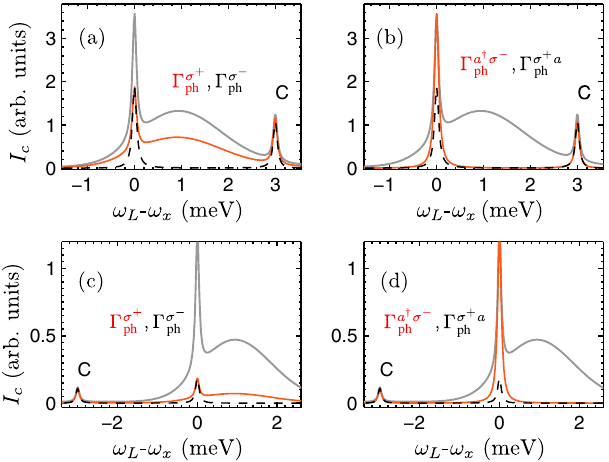
FIG. 3. (a) Influence of the effective phonon-scattering rates, (red line) and (cid:3) (cid:1) (cid:1) (dashed line) [defined in Eq. (18)], on the (cid:3) (cid:1) þ ph ph ¼ for a QD-driven system at T ¼ 4 K with (cid:1) PL intensity I c cx 3 meV . Also shown is the full polaron ME solution (grey line) ) for exciton excitation [Eq. (11)]. We plot the cavity intensity ( I c as a function of QD-laser detuning and show the contribution of one effective Lindblad rate per calculation; the collective influ- ence of these processes is shown later in Fig. 5 and compared with the full solution. (b) As in (a), but for effective phonon- (red line) and (cid:3) (cid:1) þ a (dashed line) [defined scattering rates, (cid:3) a y (cid:1) (cid:1) ph ph in Eq. (19)]. The system and material parameters are (cid:7) ¼ ¼ 40 (cid:8) eV , (cid:7) 0 ð 4 K Þ ¼ 2 (cid:8) eV , (cid:10) ¼ 50 (cid:8) eV , g ¼ 20 (cid:8) eV , (cid:4) x 2 (cid:8) eV , and we compute h B ið 4 K Þ ¼ 0 : 91 . (c)-(d) As in (a)-(b) ¼ (cid:1) 3 meV . but with (cid:1) cx mechanisms, we include only one of the Lindblad terms in each calculation, as labeled in the plots. By looking at Figs. 3(a) and 3(c), it is clear that the process L ð ^ (cid:1) þ Þ is primarily responsible for incoherently exciting the phonon